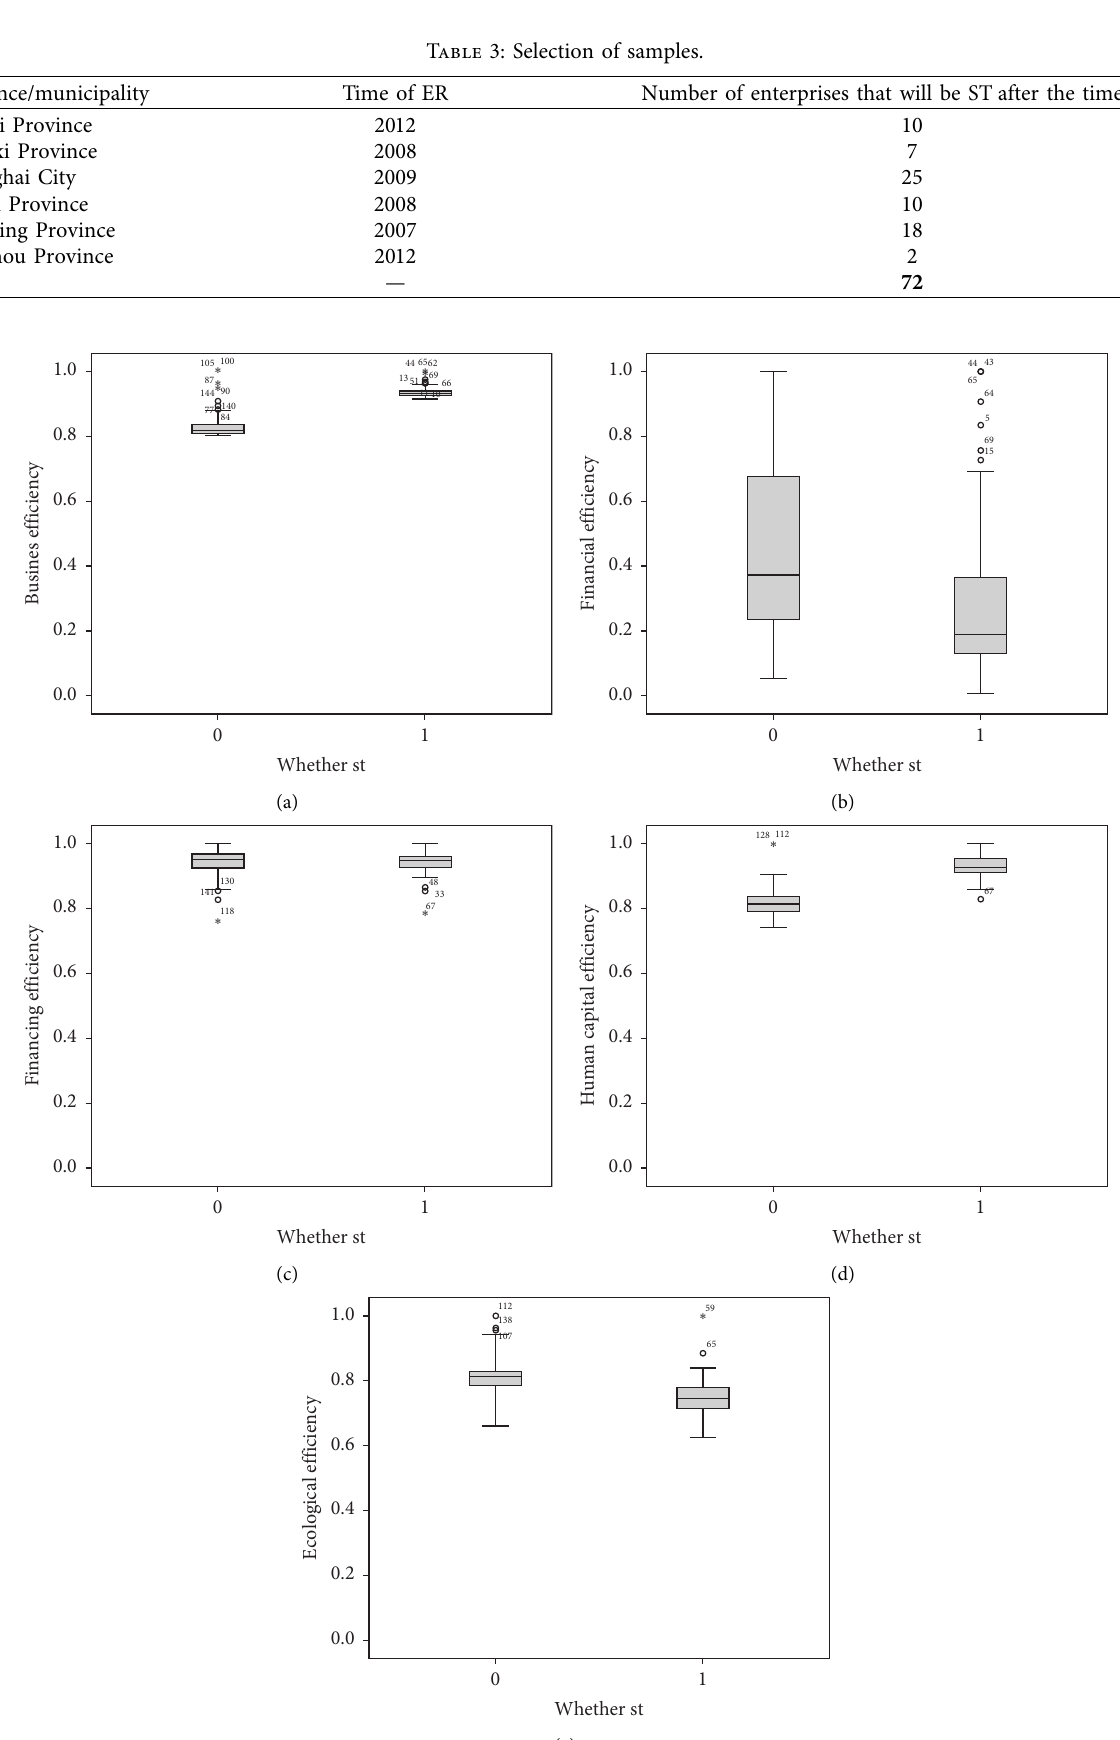
Figure 2: Comparison of ST enterprises and non-ST enterprises’ inefficiency.